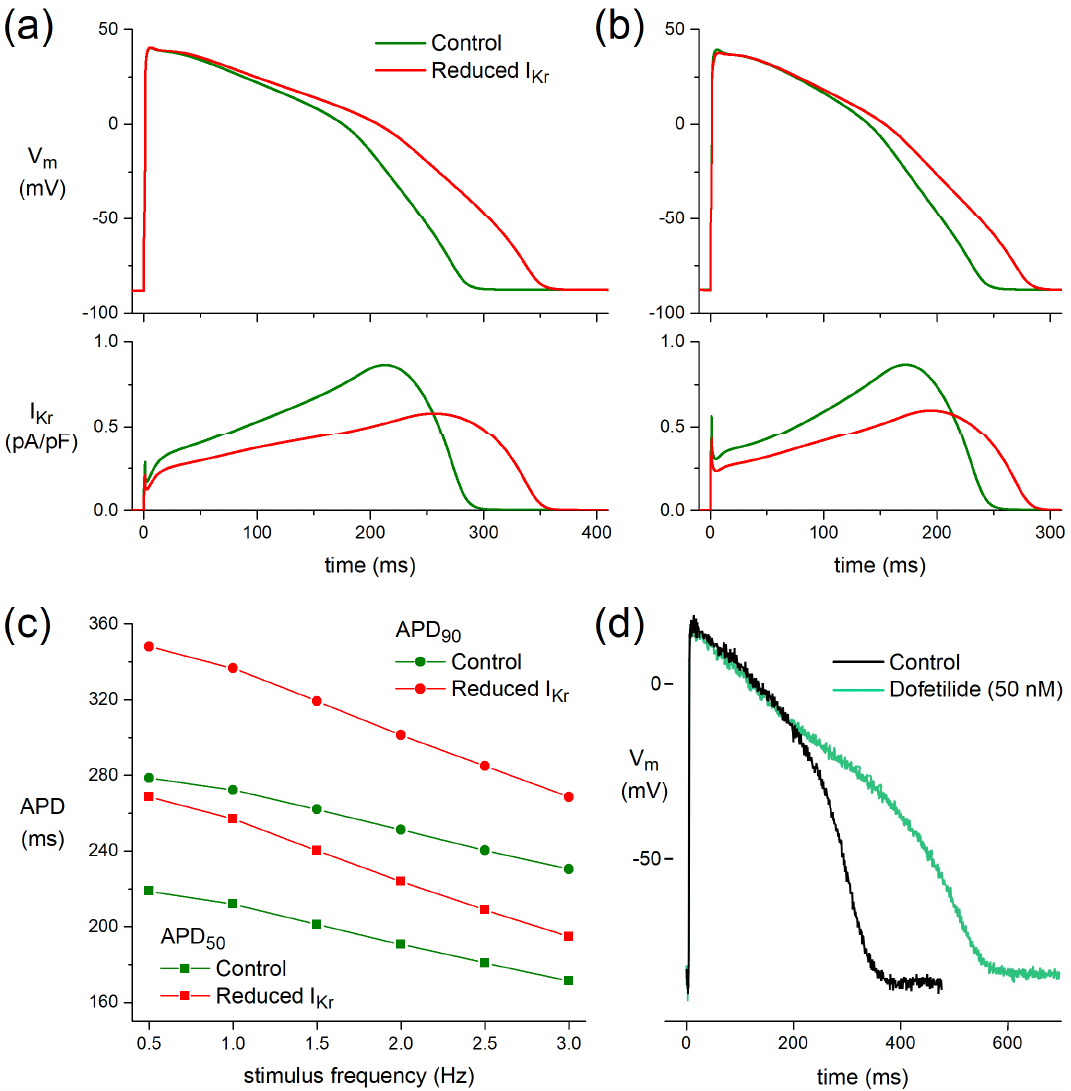
Figure 5. Functional effects of the ACh-induced reduction in I Kr on a model human ventricular cardiomyocyte (O’Hara–Rudy human ventricular cell [27]). ( a ) APs (top) and associated I Kr (bottom) at a stimulus frequency of 1 Hz. ( b ) APs (top) and associated I Kr (bottom) at a stimulus frequency of 3 Hz. ( c ) AP duration at 50% and 90% repolarization (APD 50 and APD 90 , respectively) at stimulus frequencies ranging from 0.5 to 3.0 Hz. ( d ) Human left ventricular myocardial slice: superimposed recording of APs during control and after superfusion with dofetilide (50 nM) at a BCL of 1000